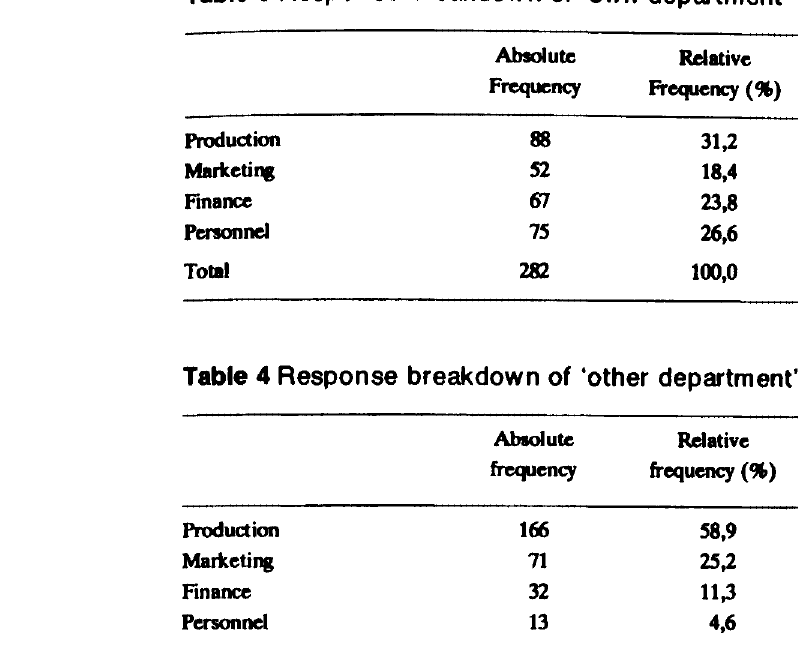
Table 3 Response breakdown of 'own department'